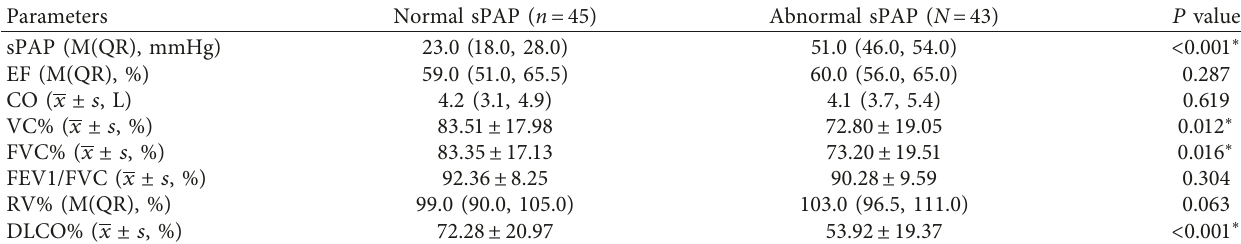
Table 2: Comparison of echocardiography and pulmonary function in patients with